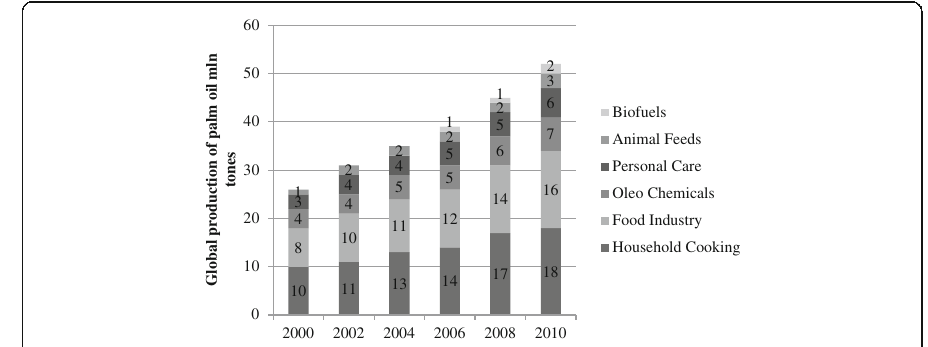
Fig. 5 Global production and use of palm oil. Source: